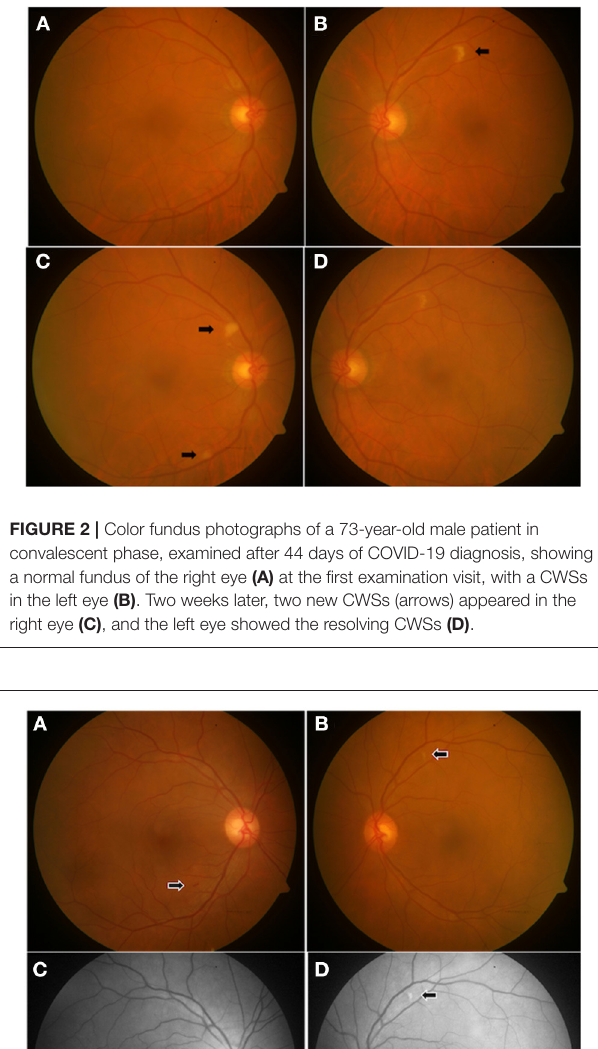
In a bedside eye screening of 43 severe COVID-19 pneumonia patients (mean age = 70 years) in Rome, Italy (11), Pirraglia et al. found unilateral chorioretinitis of opportunistic origin in one patient. None had retinal involvement due to SARS-CoV- 2. In a large series of COVID-19 patients from Iran, diabetic retinopathy (6.3%) was the only retinal finding (12).